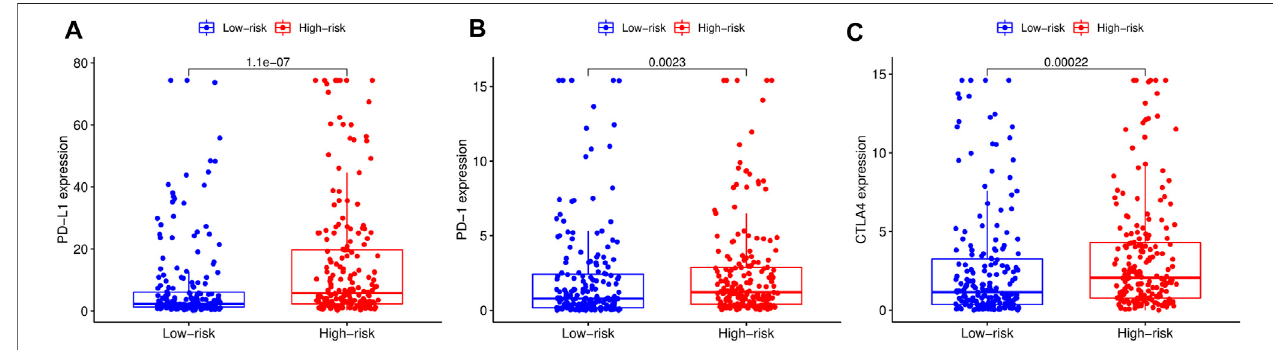
FIGURE9| Comparison oftheexpression levels ofimmunotherapeutic targets ofhigh- andlow-riskscore(RS)groups. (A) Comparison ofprogrammed celldeath ligand 1 (PD-L1) expression levels between high- and low-RS groups. (B) Comparison of programmed death 1 (PD-1) expression levels between high- and low-RS groups. (C) Comparison of cytotoxic T lymphocyte-associated protein 4 (CTLA4) expression levels between high- and low-RS